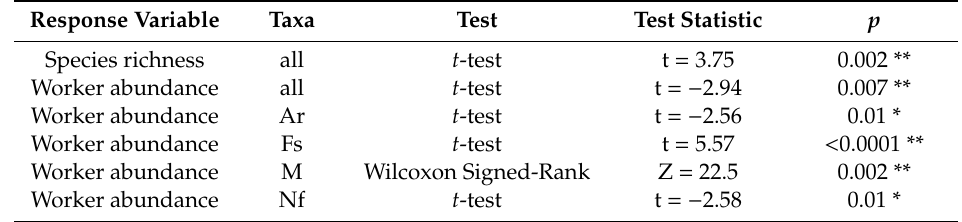
Table 5. Di ff erence in the number of species and worker of non-dominant ants recorded on baits between the day and night (day–night). The table shows significant di ff erences for parametric or non-parametric statistical tests, depending on the distribution of the data (* p < 0.05, ** p < 0.01).